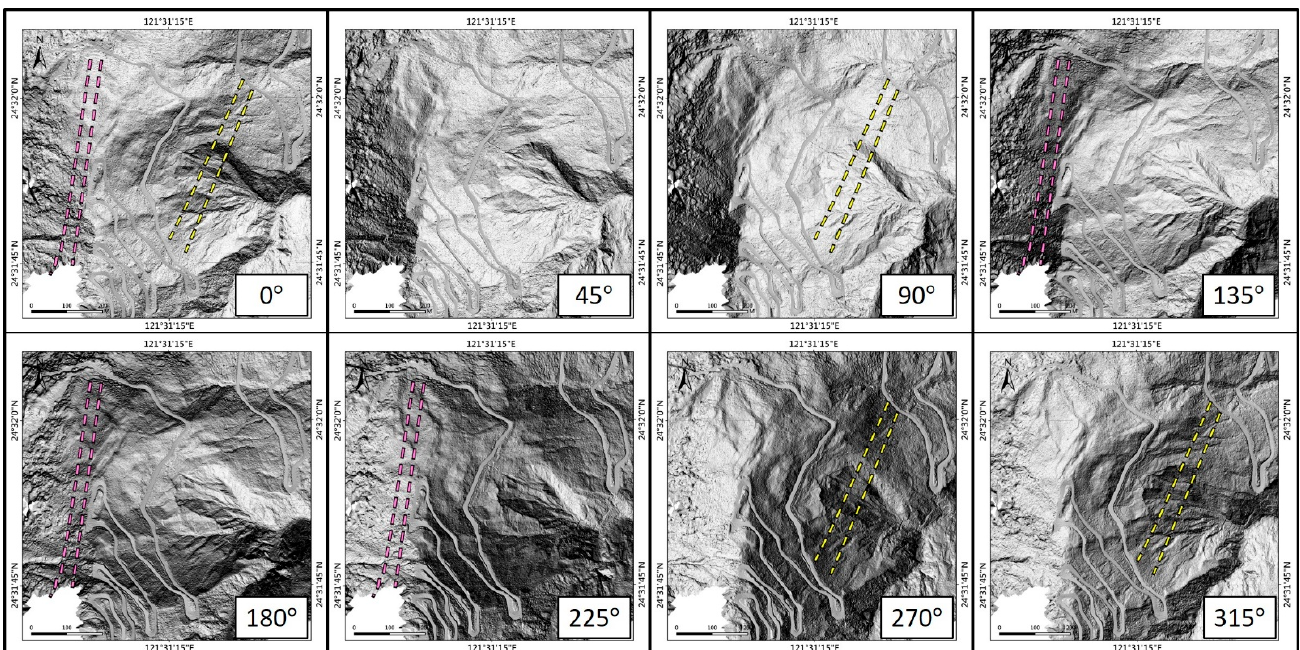
Figure 4. Illustration of the identified lineaments of geological structure using shaded relief map derived from DTMH at eight different azimuth angles: 0°, 45°, 90°, 135°, 180°, 225°, 270°, and 315°, with a light incidence angle of 45° (WGS 84 coordinates). The yellow dash lines marked the lineaments on the main slope face observed at the azimuth angles of 0°, 90°, 270°, and 315°; and purple dash lines marked the lineaments on opposite slope face observed at the azimuth angles of 0°, 135°, 180°, and 225°.